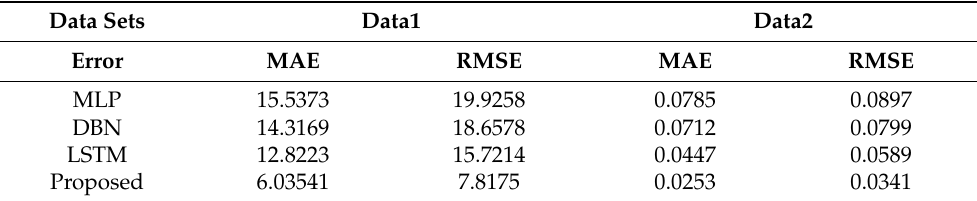
Table 4. Comparison of prediction results of various methods under different data